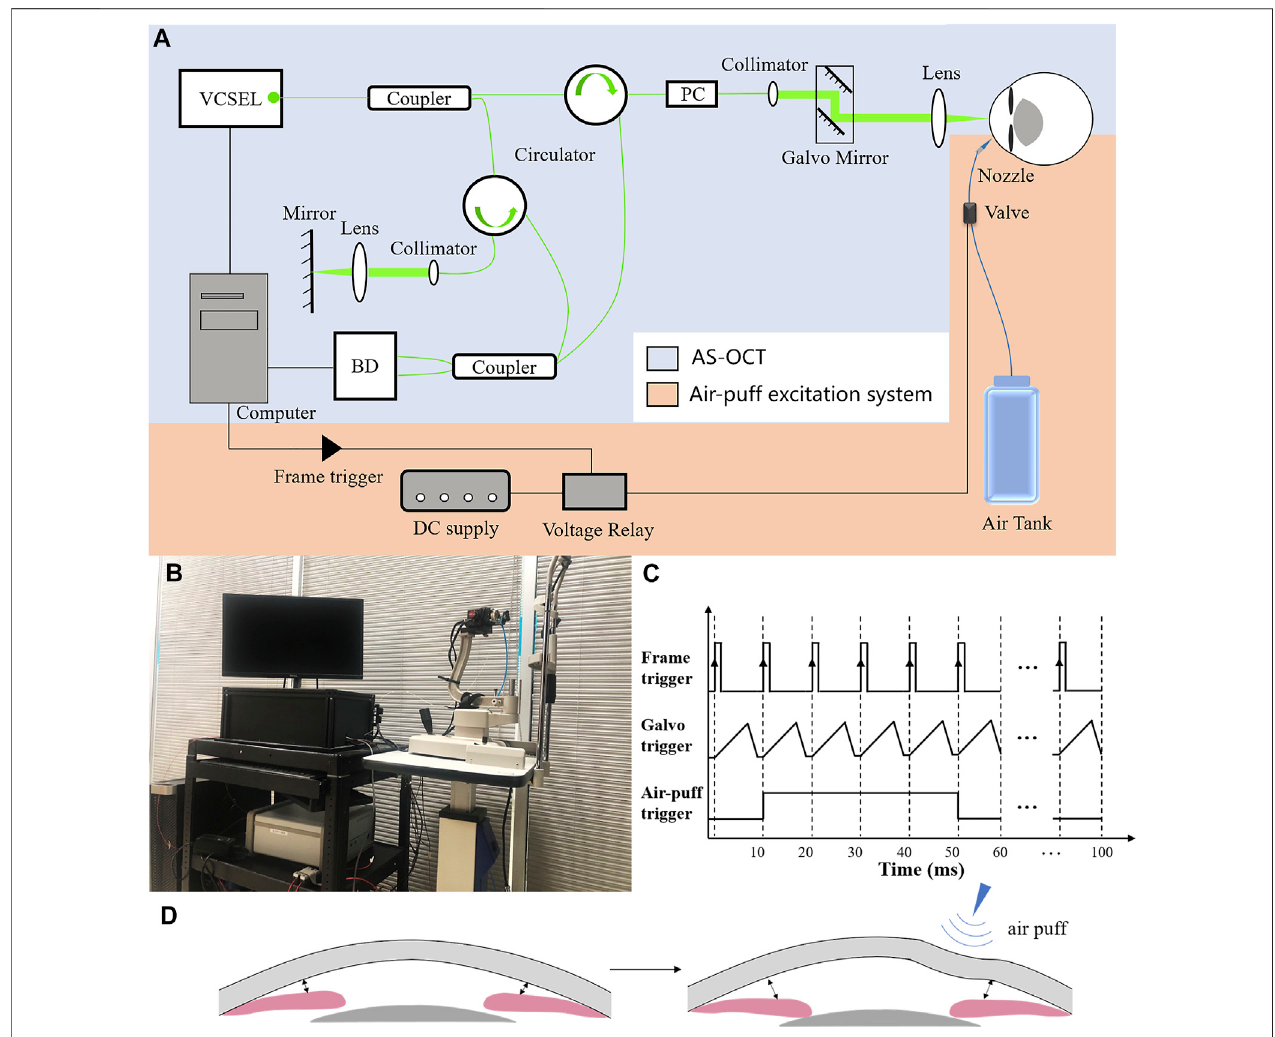
FIGURE 1 | Principle diagram of the air-puff DAS-OCT system. (A) , Schematic representation of the DAS-OCT system. VCSEL, vertical cavity surface-emitting laser light source; PC, polarization controller; BD, balanced photodetector. (B) , Actual administration of the DAS-OCT system; (C) , Timing diagram of the DAS-OCT system; (D) , Schematic illustration of normal anterior segment structural changes caused by the air puff.